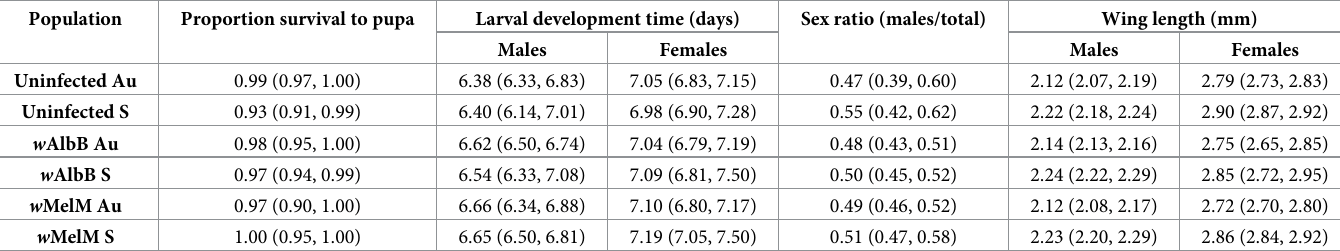
Table 2. Larval development and size of Wolbachia -infected and uninfected Aedes aegypti from Australian and Saudi Arabian backgrounds. Medians and confi- dence intervals (lower 95%, upper 95%) are shown for each trait. Population Proportion survival to